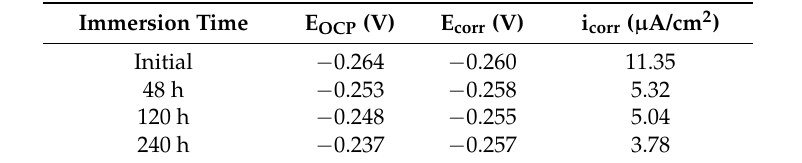
Table 2. Electrochemical corrosion parameters of specimens after different immersion time in 3.5 wt % NaCl solution.